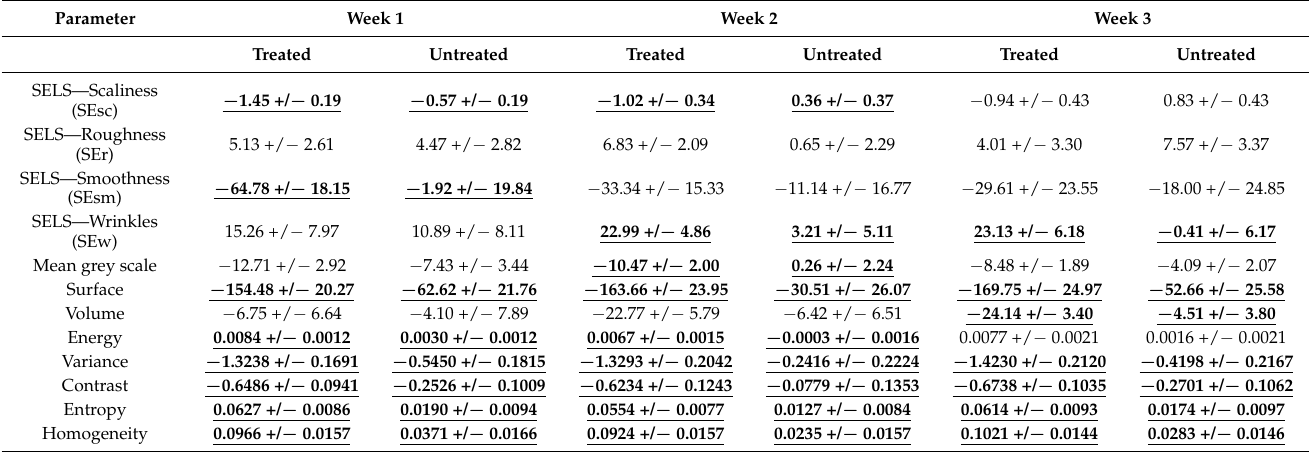
Table 2. Visioscan ® VC 20plus data change from baseline at the end of Week 1, 2, and 3. Statistical differences between the Treated and Untreated sites (multifactorial ANOVA) with >95% significance ( p < 0.05) are shown in bold and underlined. Data for the SEsc, SEr, SEsm, SEw, mean grey scale, surface and volume scores is given to two decimal places, while the Energy, Variance, Contrast, Entropy and Homogeneity scores are shown to four decimal